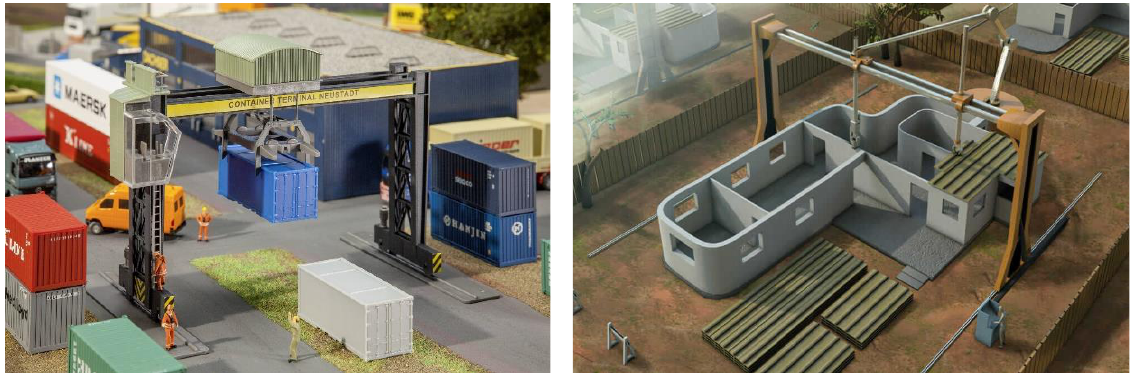
Figure 2: Overhead crane vs Gantry Concrete Printer